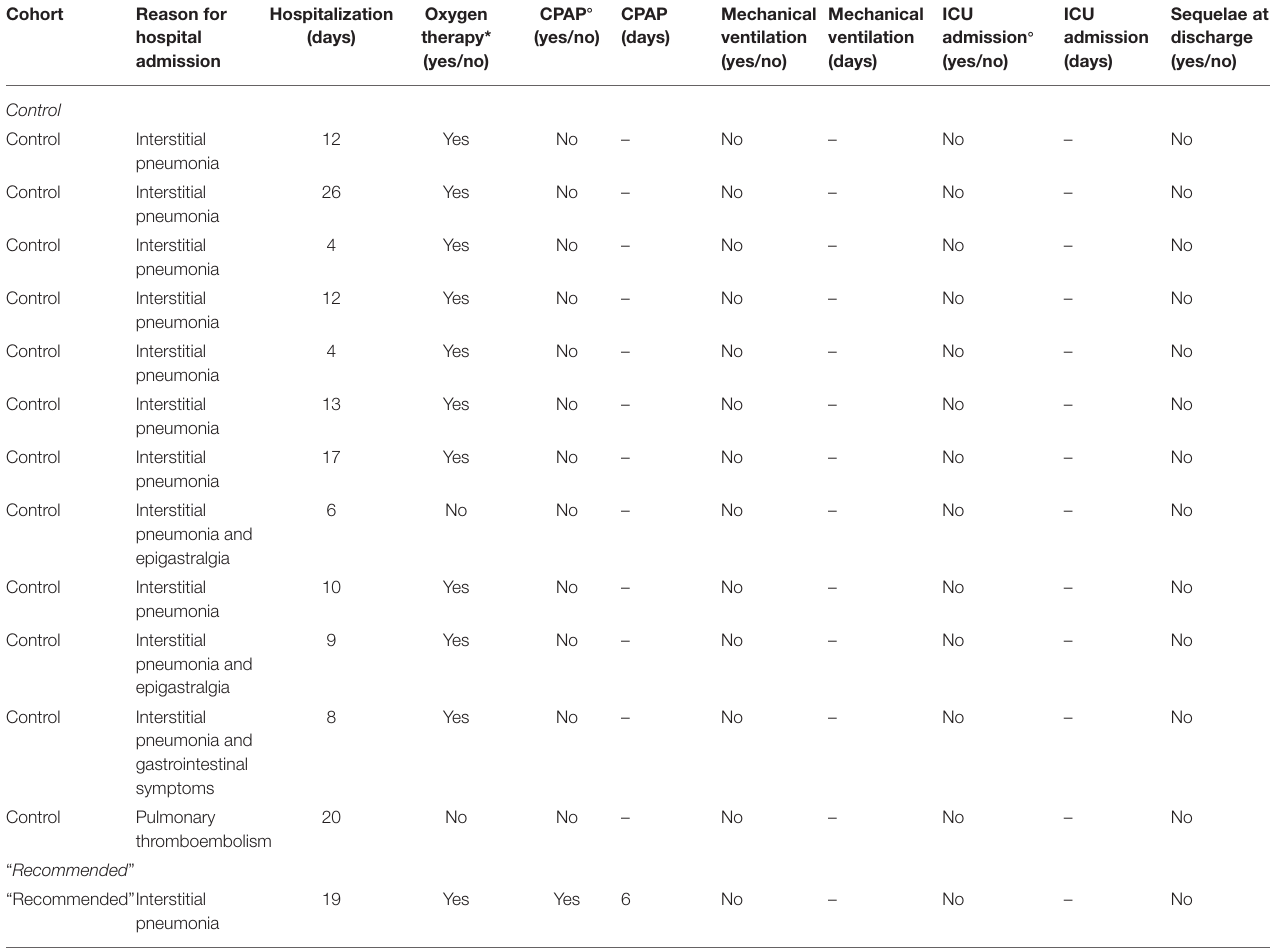
TABLE 2 | Clinical course of hospitalized patients in the two cohorts.